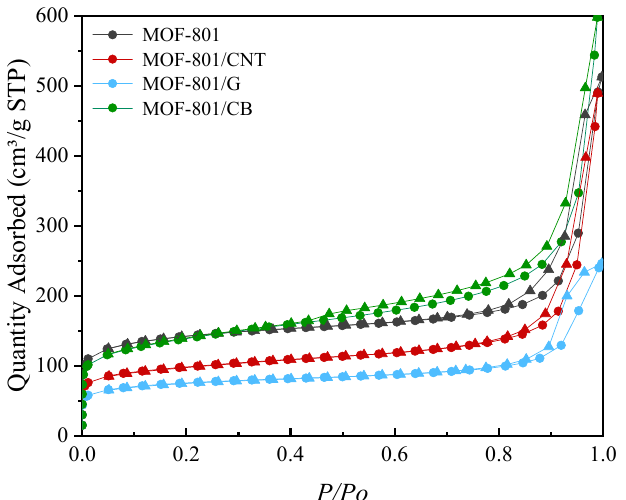
Figure 4. The N 2 sorption isotherms at 77 K of MOF-801, MOF-801/CNT, MOF-801/G, and MOF- 801/CB.